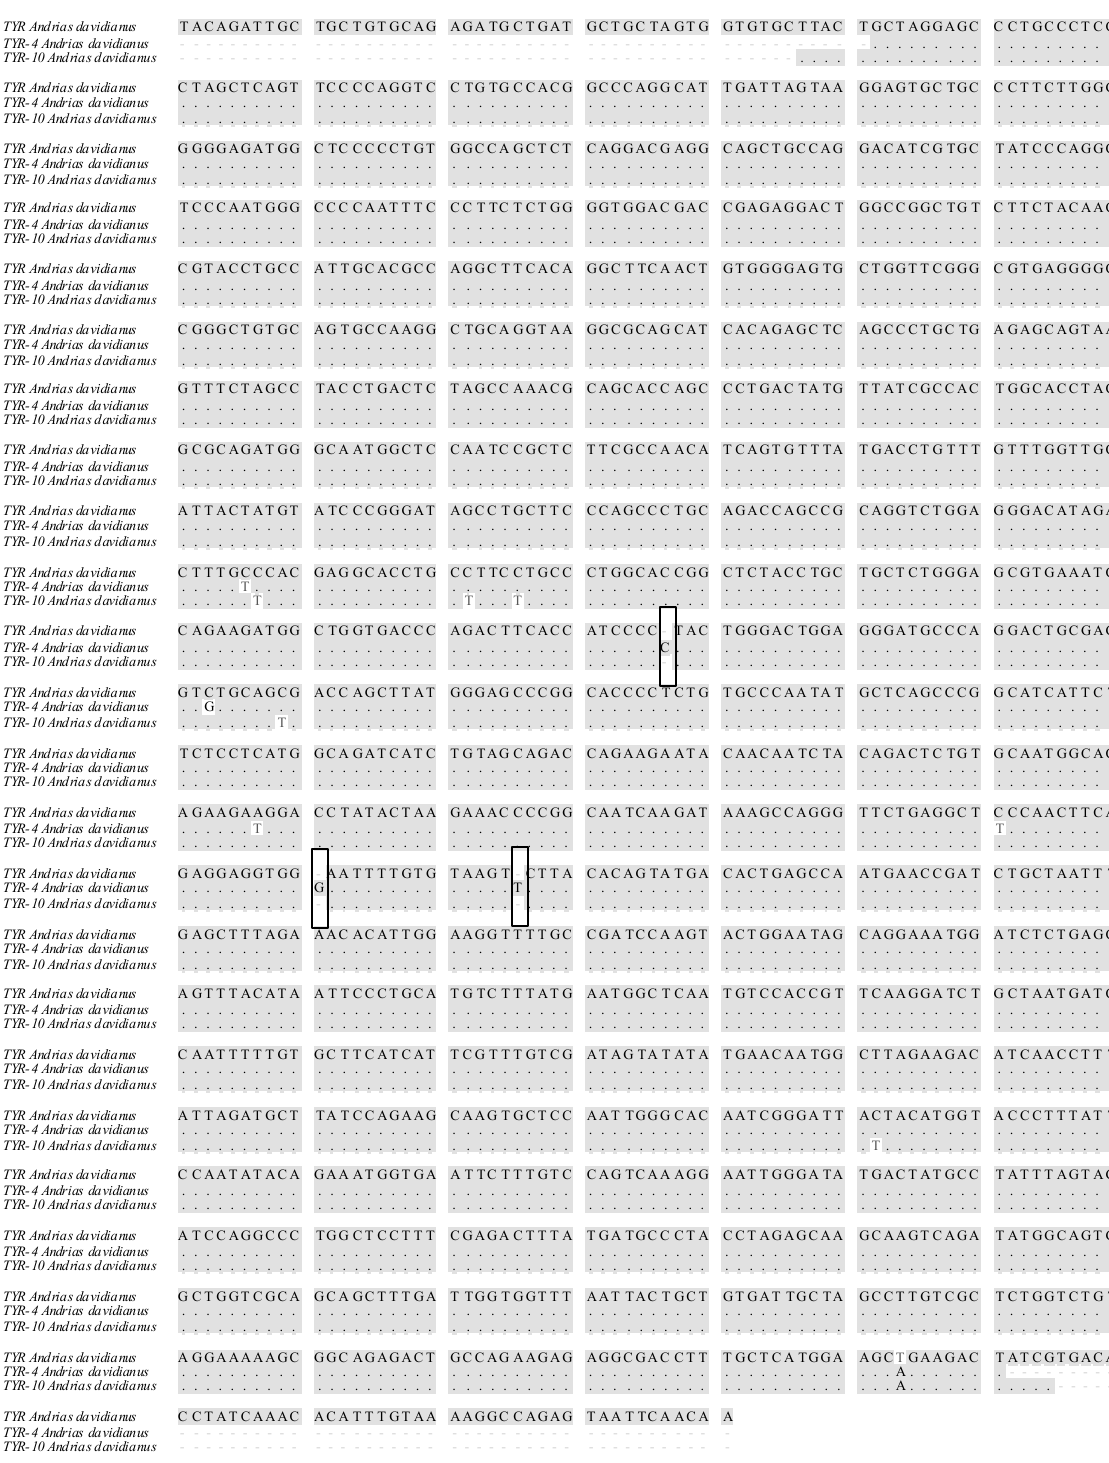
Figure 11. Multiple alignment of TYR sequences of individuals with different body colors. Note: Three nucleotide insertion sites are indicated by □ . TYR represents GY phenotype, TYR-4 represents YL phenotype, TYR-10 represents intermediate phenotype.